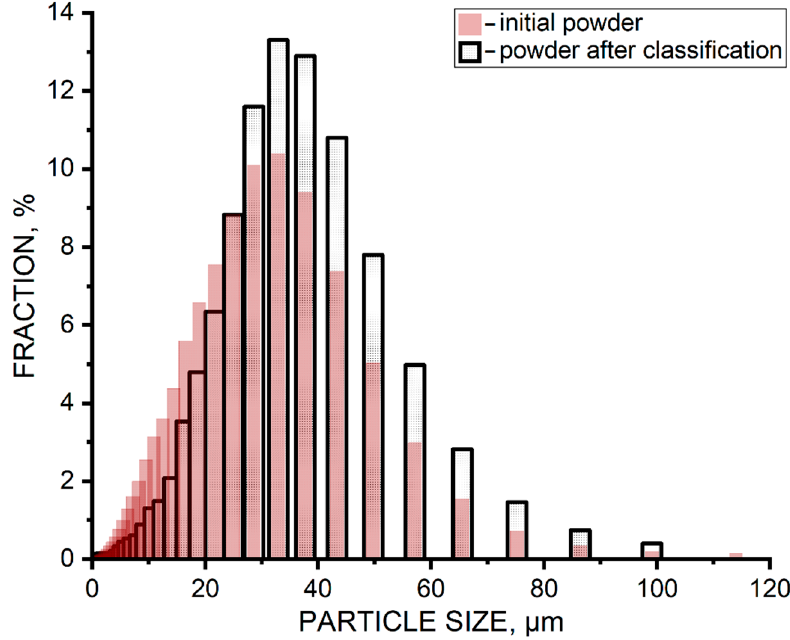
Figure 5. Particle size distribution comparison of ASP-30 powder.